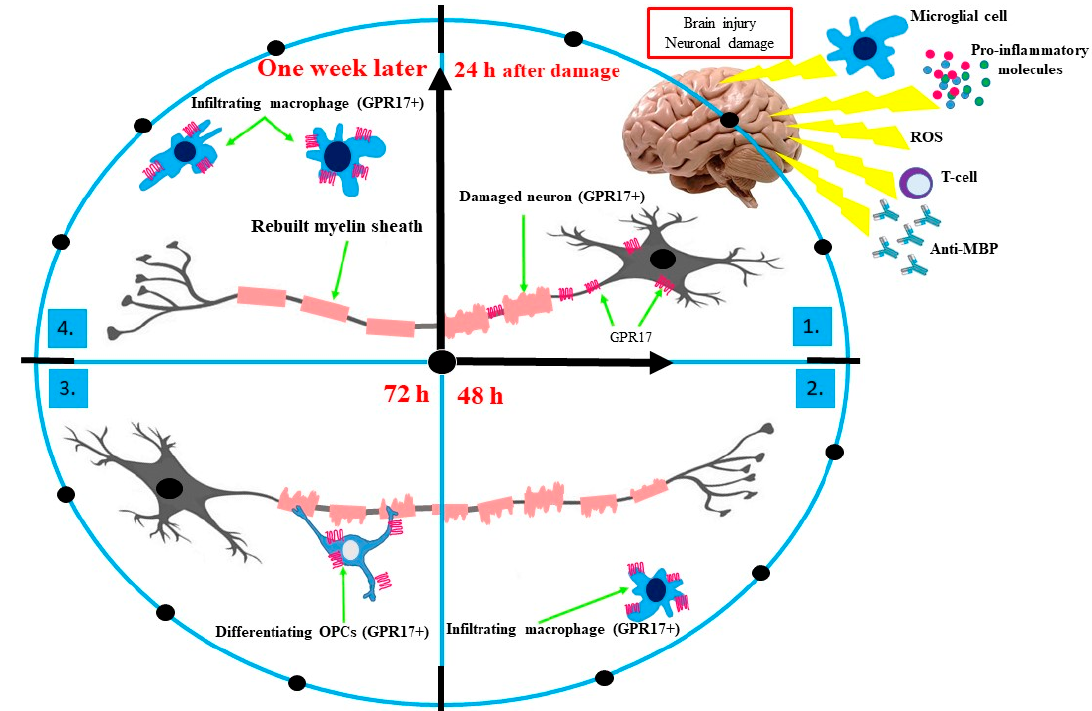
Figure 1. The role of GPR17 receptors as a specific marker of CNS damage. In the early stage of CNS tissue injury (within 24 h), an increased level of GPR17 is observed in damaged neurons and there is considerable growth in the mortality of GPR17+ neurons ( 1 ). Once 48 h have passed since axonal damage, GPR17 receptors are not located on injured neurons, but only at the limit of the nerve tissue damage due to exposition on the surface of infiltrating macrophages (activated microglial cells) ( 2 ) Once 72 h have passed since damage, a proliferation of OPCs (GPR17+) is observed. Expression of GPR17 on the surface of OPCs blocks their differentiation and maturation into myelinating OLGs. Myelination is possible after losing the GPR17 receptors by OLGs ( 3 ). One week after brain injury, the GPR17 level again enhances in the area of damage and is associated with the resumed massive infiltration of macrophage cells that previously resided on the edge of the damage site ( 4 ). Abbreviations: anti ‐ MBP, anti ‐ major basic protein; GPR17, G ‐ protein coupled receptor 17; OPCs, oligodendrocyte precursor cells; OLGs, oligodendrocytes; ROS, reactive oxygen species.